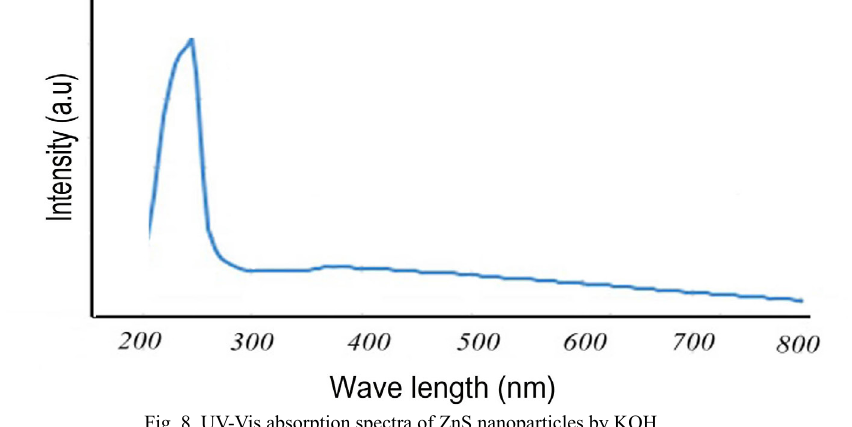
Fig. 8. UV-Vis absorption spectra of ZnS nanoparticles by KOH